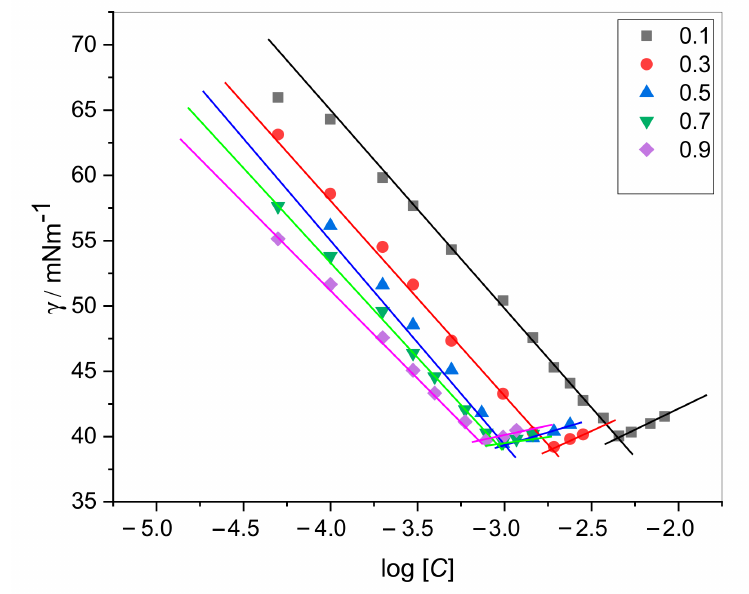
Figure 2. Surface tension ( γ ) vs. log [ C ] plots for CPC + DPH mixed